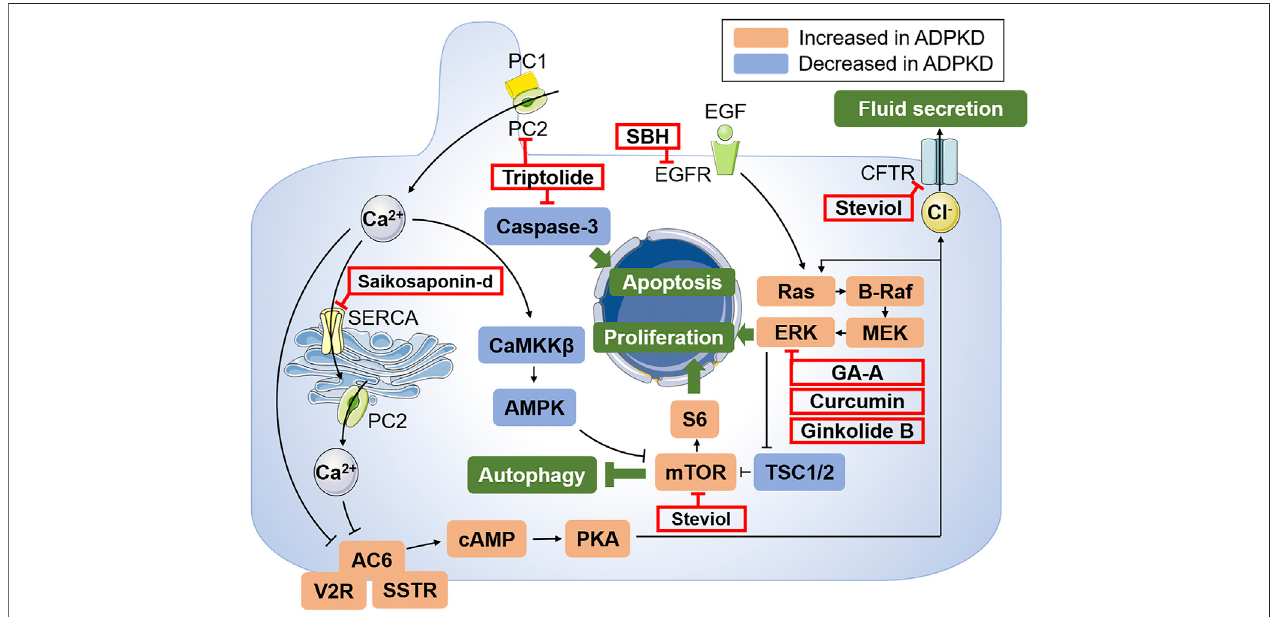
FIGURE1| SchematicillustrationofthekeymechanismsofADPKDpathogenesisandtargetsofpotentialtreatmentsofherbalmedicines.PC1andPC2expressin different subcellular locations and aberrant function of PC1 and PC2 results to decreased intracellular Ca 2+ and subsequent activation of cAMP via AC6. Abnormally increased cAMP leads to the activation of PKA, activating Ras/B-Raf/MEK/ERK and mTOR signaling pathways through inhibiting TSC1 and TSC2, which drive cell proliferation. Moreover, the activated PKA can also promote the transport of Cl − into the cyst cavity via CFTR, thus causing increased cyst fl uid secretion. Autophagy can also be induced by Ca 2+ -mobilizing agents by activating the CaMKK β -AMPK-mTOR signaling cascades. In addition, EGF activates Ras and promotes cellproliferationbybindingtothecorrespondingreceptor. Thetargetsofcandidatedrugsaredepictedasredboxes.Abbreviations:PC1,polycystin-1; PC2,polycystin- 2; AC6, adenylyl cyclase six; V2R, vasopressin type 2 receptor; SSTR, somatostatin receptor; cAMP, cyclic adenosine monophosphate; PKA, protein kinase A; CFTR, cystic fi brosis transmembrane conductance regulator; EGF, epidermal growth factor; EGFR, epidermal growth factor receptor; MEK, mitogen activated protein kinase; ERK, extracellular-signal regulated kinase; TSC, tuberous sclerosis; mTOR, the mammalian target of rapamycin; SERCA, sarcoplasmic/endoplasmic reticulum Ca 2+ atpase; CaMKK β , Ca 2+ /CaM-dependent protein kinase β ; AMPK, AMP-activated protein kinase; GA-A, ganoderic acid A; SBH, Sparganum stoloniferum